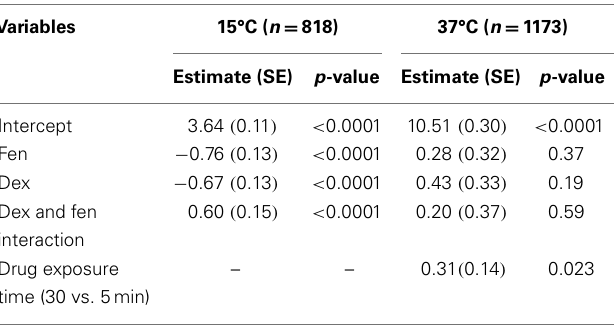
Table 1 | Drug–drug and Drug–time interaction on ciliary beat frequency .